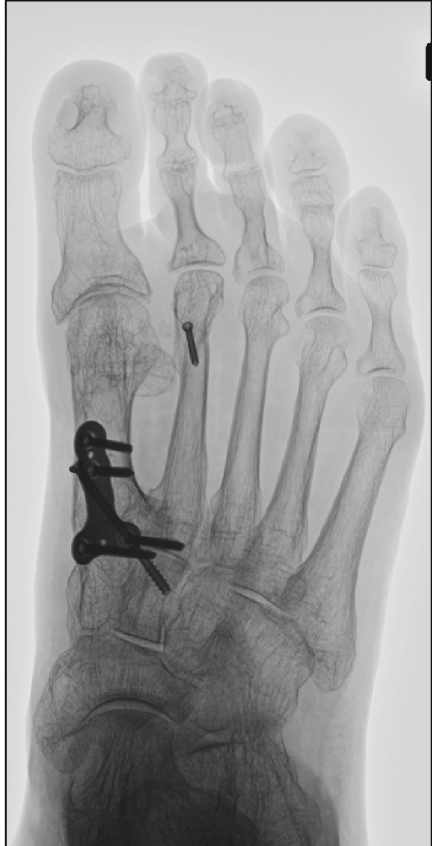
Figure 5: Radiograph one year postoperatively. The hallux valgus angle was 4 ° and the intermetatarsal angle 8 °